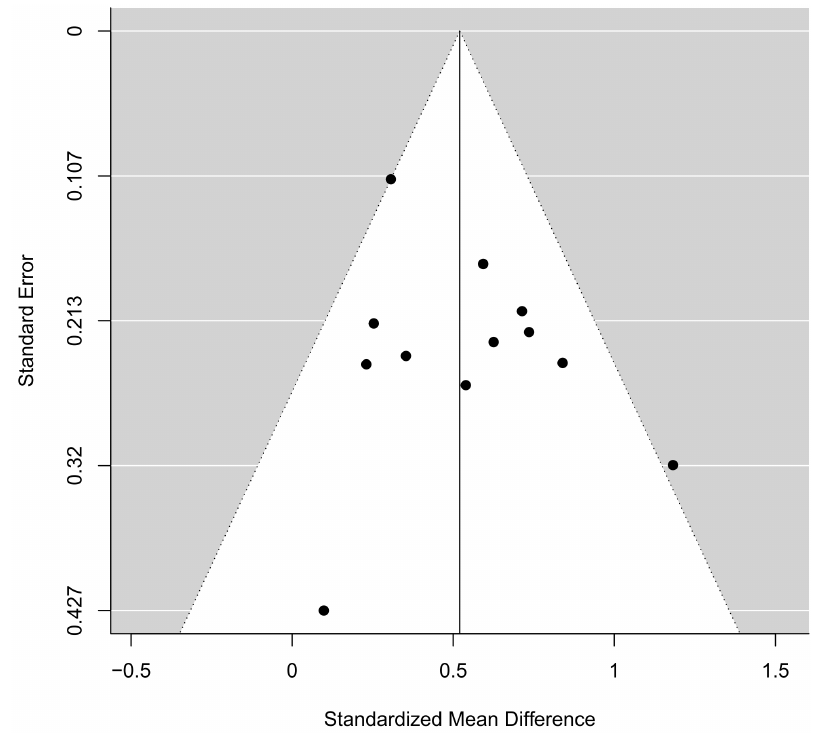
Fig. 2. Results of a publication bias analysis using the funnel